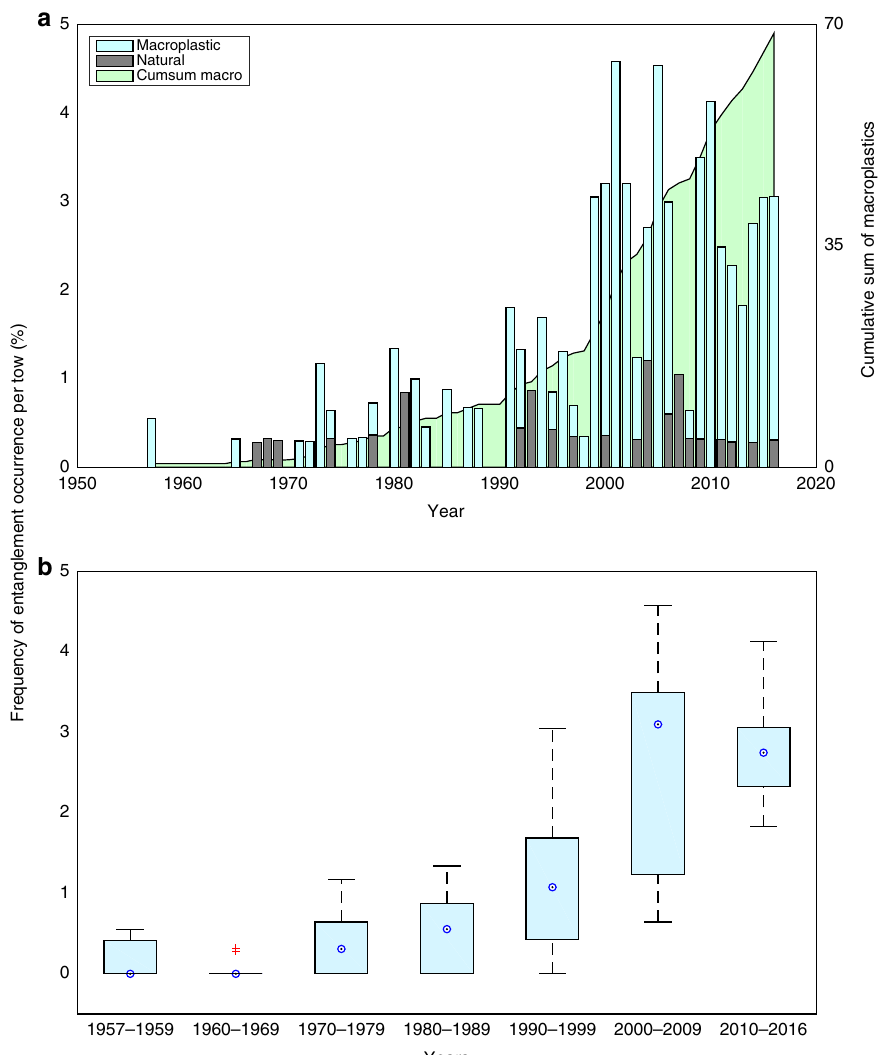
Fig. 1 Total macroplastic and natural counts of entanglement. a annual counts of macroplastic = light blue bars (signi fi cant trend = 0.057± 0.0066 (1S.D.)), and natural items = grey bars (non-signi fi cant trend = 0.0045 ± 0.0028 (1S.D.)). The cumulative sum of the total counts of macroplastic are plotted on the second y -axis in green. b total counts of macroplastic per decade plotted as a box and whisker plot, where the median is represented by a blue circle, the edges of the box are the 25th and 75th percentiles, the whiskers extend to the most extreme data points, and outliers are plotted individually as red crosses. Please note there are only 3 years of data for the 1950s (1957 – 1959) and only 7 years of data for the 2010s (2010 – 2016). The annual counts of entanglements observed have been normalised to a percentage frequency of occurrence per Continuous Plankton Recorder tow